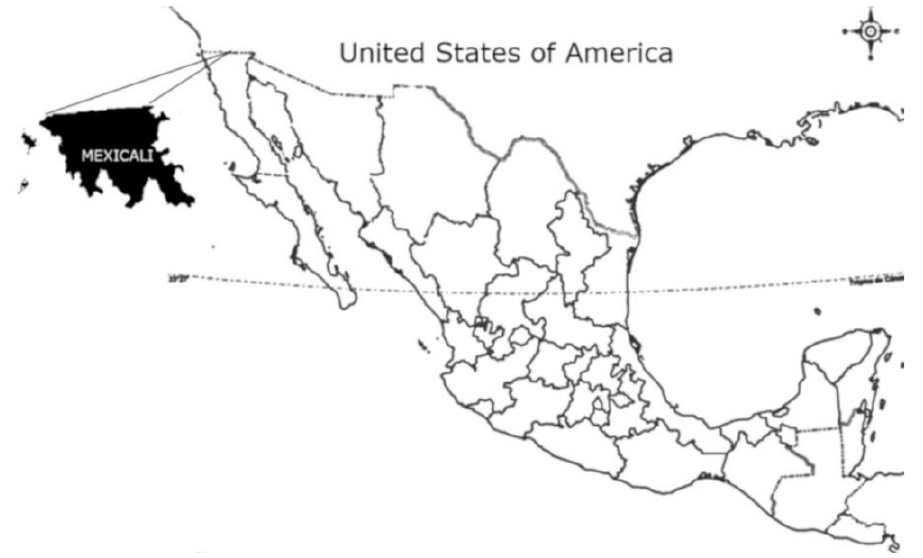
Figure 1. Location of the city Mexicali, Mexico.